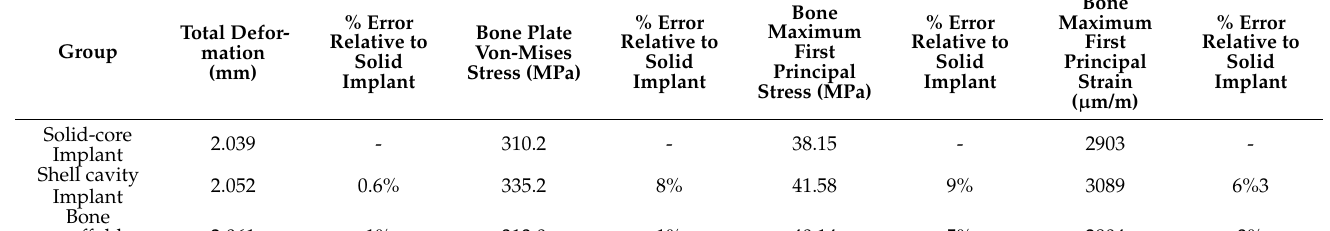
Table 3. FE analysis of total displacement, bone plate von-Mises stress, bone maximum first principal stress and bone maximum first principal strain for all simulated models.